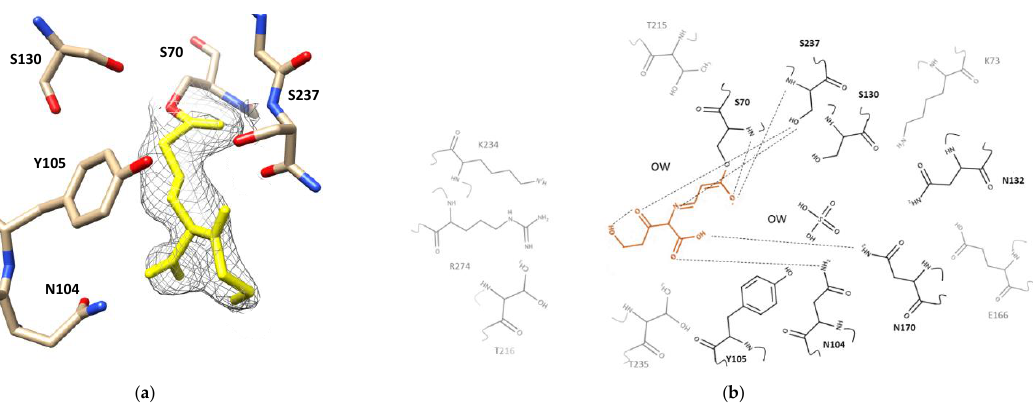
Figure 3. Active site of CTX-M-15 Clavulanic acid-enzyme complex. ( a ) Electron density map of CTX-M-15 active site bound to clavulanic acid shown in yellow. 2Fo-Fc map (contoured at 1.0 sigma) is shown in grey which was built by UCSF Chimera v1.13.1 (San Francisco, CA, USA). Residues around the binding pocket of the clavulanic acid-CTX-M-15 crystal structure are depicted as cream, red, blue sticks. ( b ) 2D structure of clavulanic acid (orange) in the binding pocket of CTX-M-15. All residues have been shown, hydrogen bonds are drawn using dashed lines. The residues that interacted with clavulanic acid are in dark black, residues without interaction are shown in gray. The figure was built by the MarvinSketch v.17.28.0. (Budapest, Hungary).